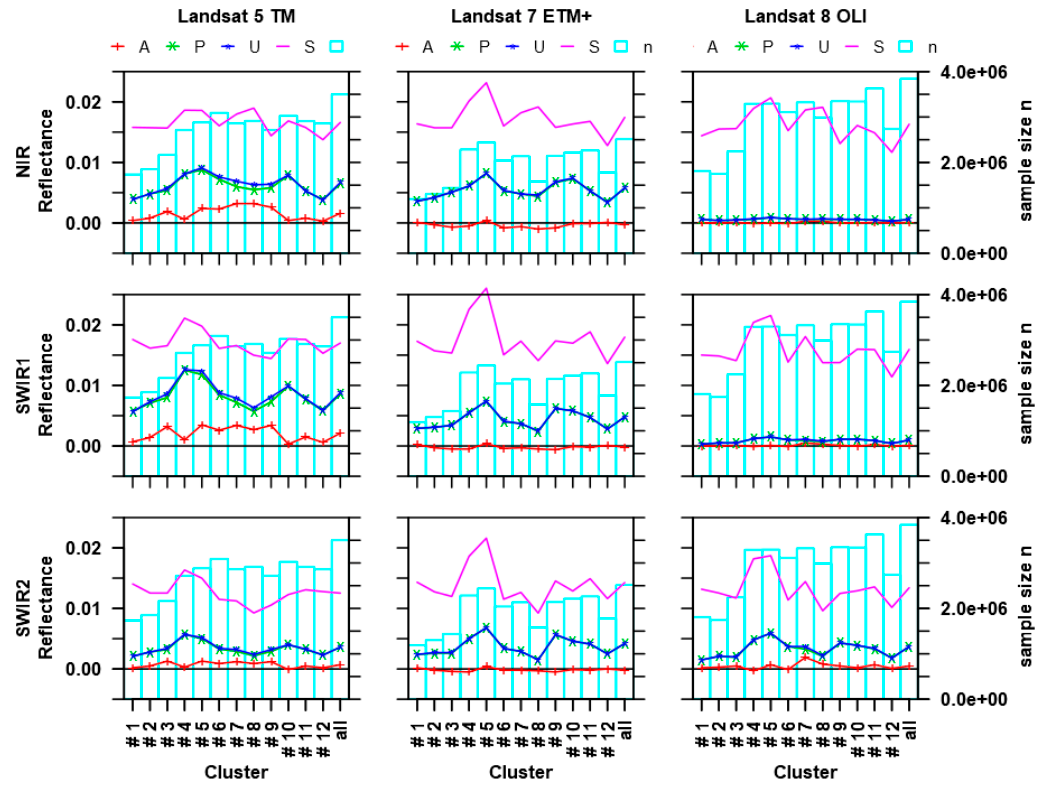
Figure 9. Accuracy, precision, and uncertainty (APU, left y-axis) for each cluster (Figure 5). Landsat sensors are arranged in columns, and NIR and SWIR bands are arranged in rows. For each case (e.g., Cluster #1, Landsat 5, NIR), an APU plot was generated, and visualized here are the overall APU statistics (which are shown as text in the legend of Figure 8). Thus, the ‘all’ Clusters are identical to the values presented in Figure 8, and are included in Figure 9 for interpreting the regional differences with regards to the global assessment. Colors and signatures are as in Figure 8. The cyan bars are the number of samples in each cluster (right y-axis). The magenta line represents the specified theoretical uncertainty based on the mean surface reflectance truth.